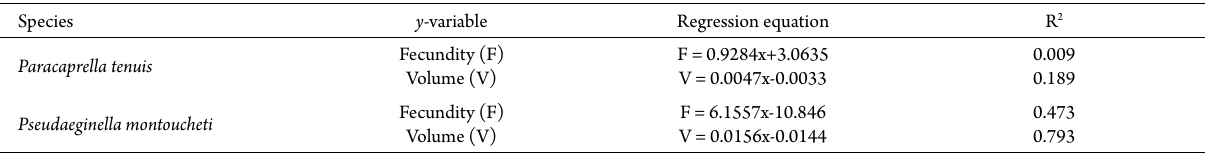
Table 1. Regression analyses based on the ovigerous female length (TL) as x -variable for Paracaprella tenuis and Pseudaeginella montoucheti